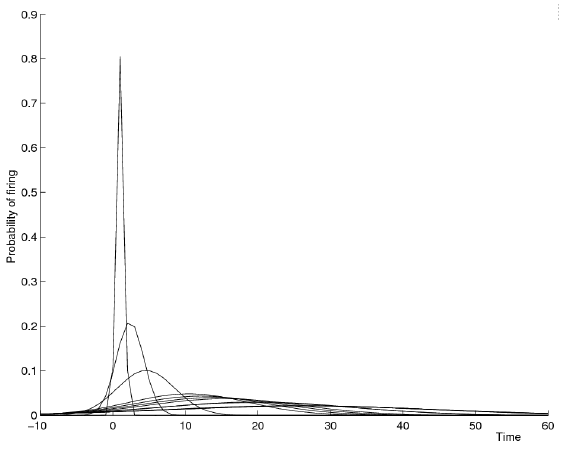
Figure 4. The Gaussian peaks for successive sensor firings after a given sensor event on a